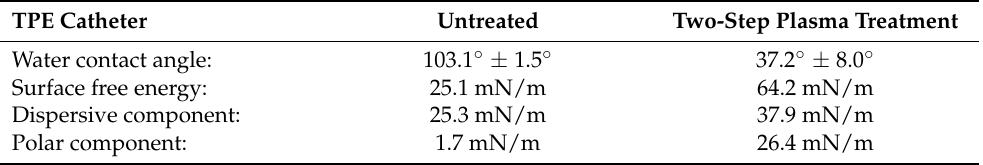
Table 4. Wettability, surface-free energy (SFE), the disperse and polar components of SFE for TPE catheter.